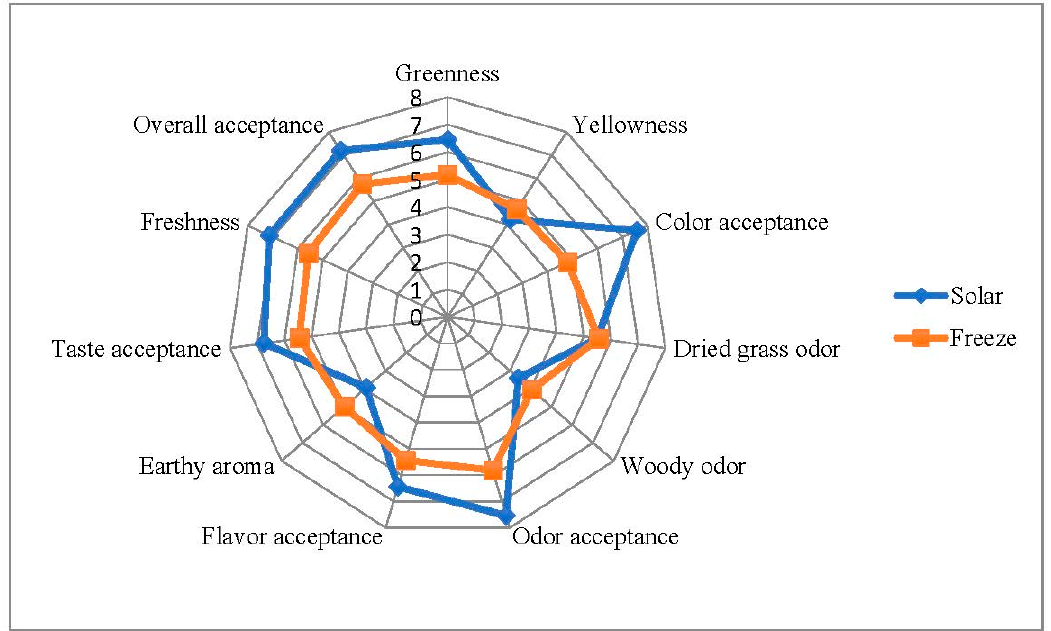
Figure 5. Mean score of sensory analysis for freeze-and solar-dried O. syriacum based on 11-point hedonic scale.